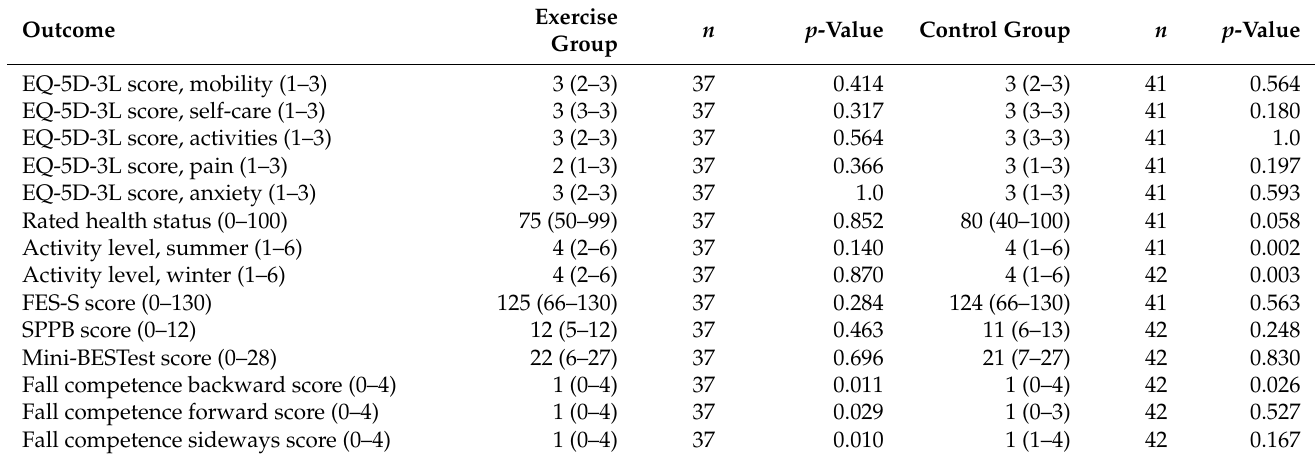
Table 2. Descriptive statistics at the 20-month follow-up and within group analysis.